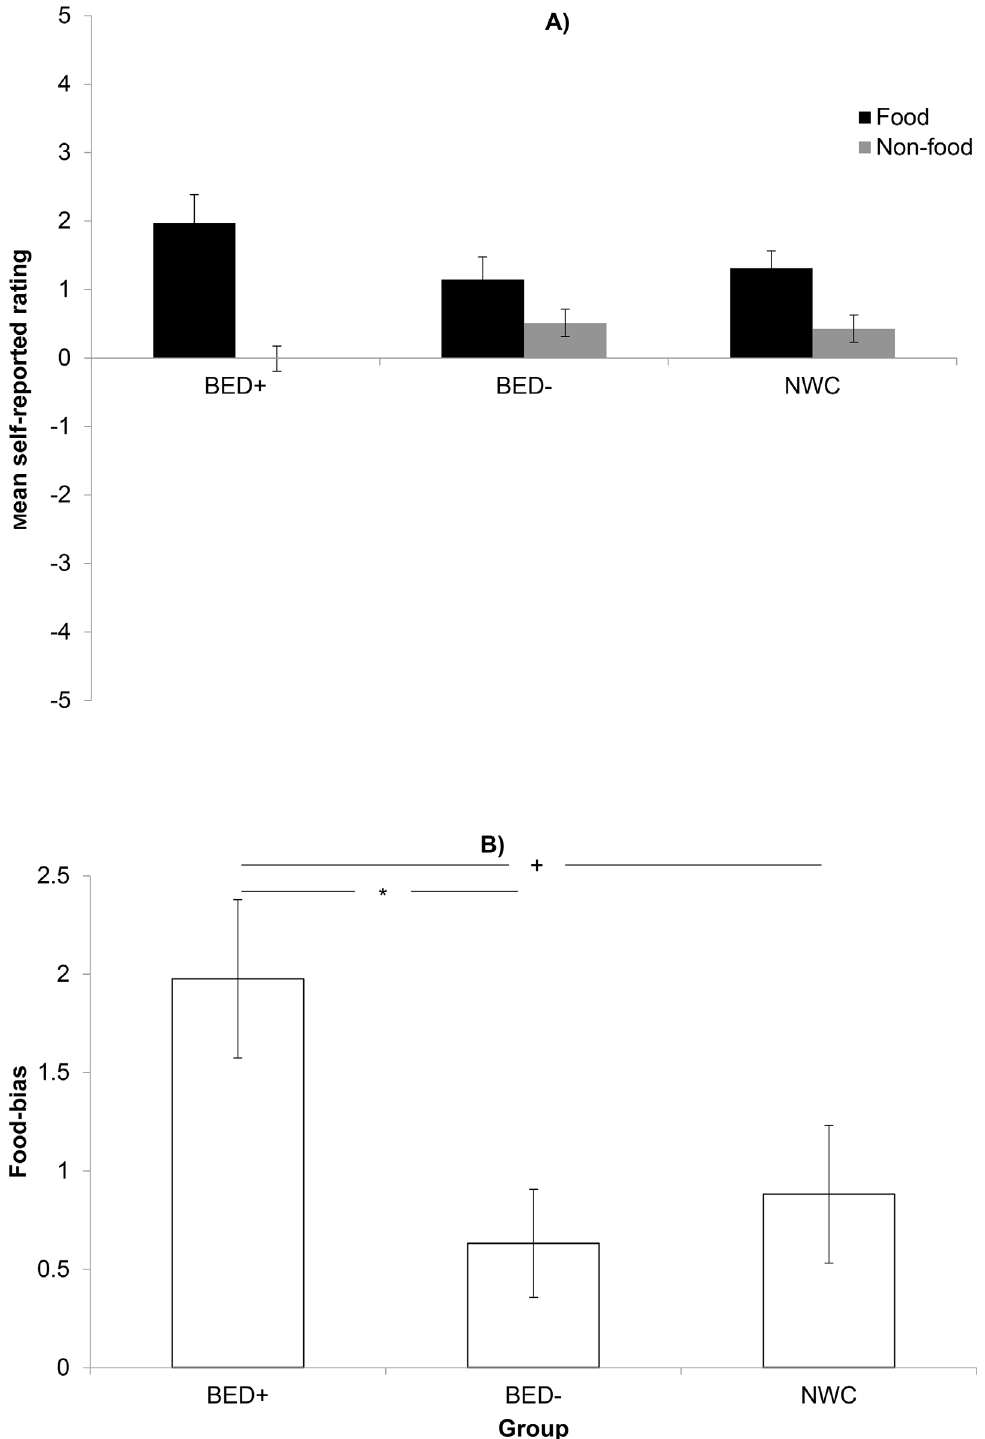
Fig 2. Mean self-reported valence of food versus non-food stimuli in all three groups. BED+ = overweight participants with BED according to DMS-IV, BED- = overweight controls without BED, NWC = age-matched, normal weight healthy controls. * indicates significant differences after Bonferroni correction ( p < .017), + indicates significant differences with p-values <